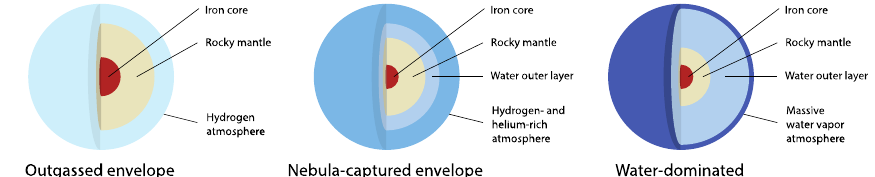
Figure 2. Schematic of concepts for sub Neptune interior and envelope composition. Left : A sub Neptune may have a massive core and mantle surrounded by an outgassed H 2 envelope with low atmospheric water vapor content. Middle : A sub Neptune may have a core and mantle surrounded by a water layer itself covered by an H 2 –He envelope. Right : A water world composed of 50–90% water by mass will have a water-dominated atmosphere and interior. The inner water layer may include a water ocean, a supercritical water layer, and high - pressure water ice. Adapted from [13].